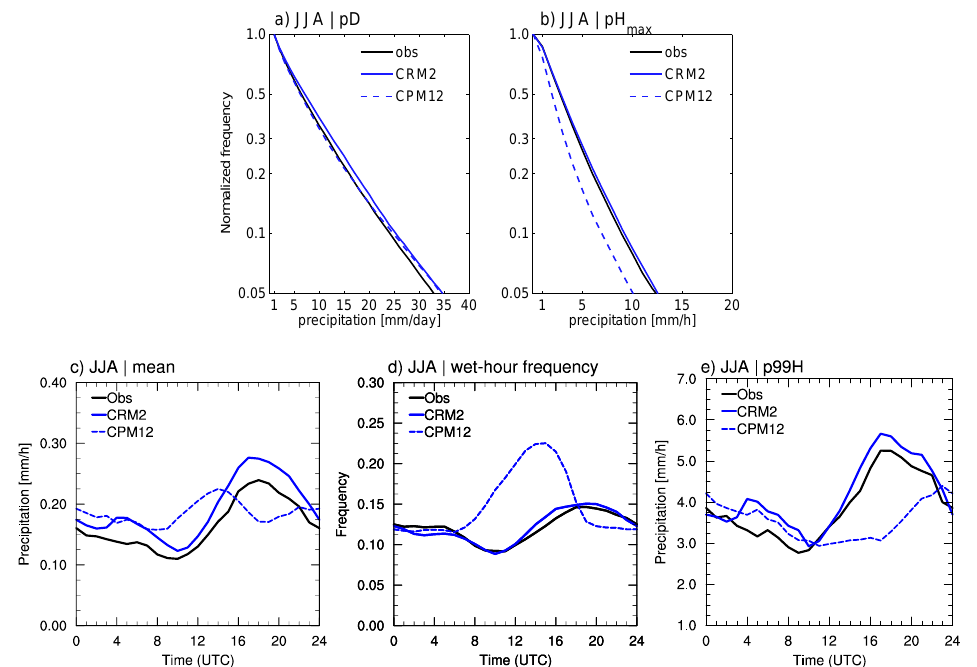
Figure 7. Comparison of precipitation from reanalysis-driven simulations with 12km (CPM12, dashed 1 blue) and 2.2km (CRM2, solid blue) horizontal resolutions with parameterized and explicit convection, respectively. Cumulative frequency distribution of ( a ) daily precipitation and ( b ) daily maximum 1h precipitation, expressed relative to the number of wet days. Mean diurnal cycle of ( c ) mean precipitation, ( d ) wet-hour frequency, and ( e ) heavy hourly precipitation (p99H, 99th percentile of all hours). From [128] c (cid:13) Copyright 2015 American Meteorological